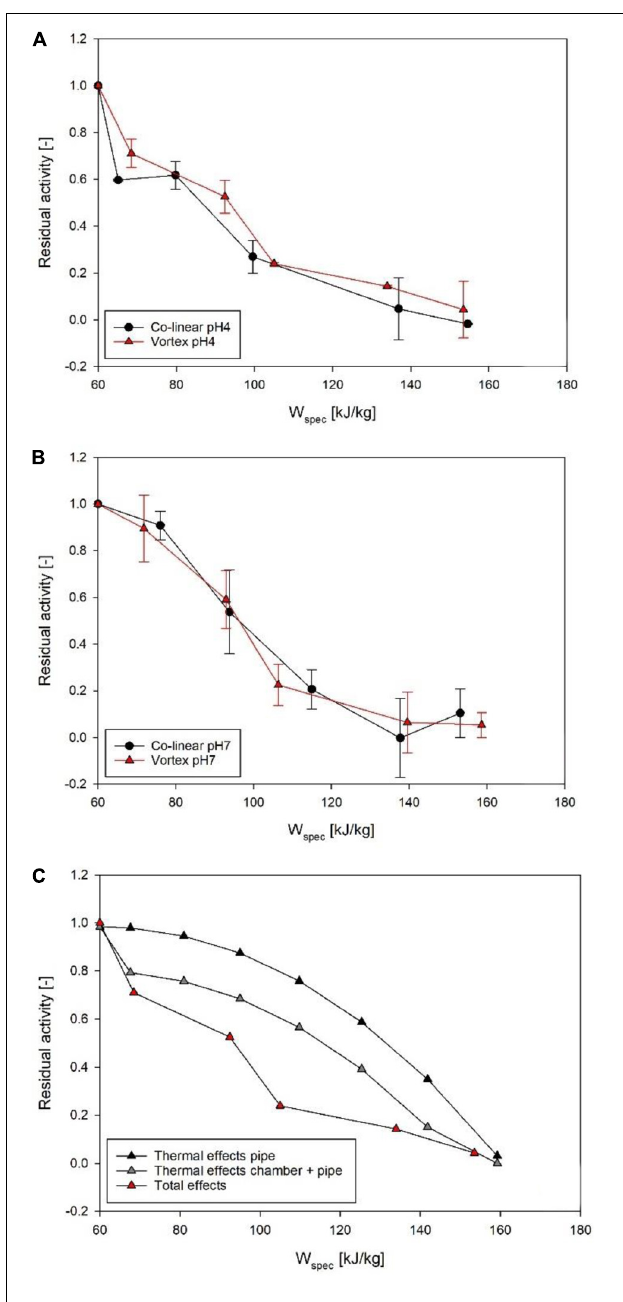
FIGURE 9 | Comparison of ALP inactivation kinetics of co-linear (black circles) and vortex (red triangles) configuration at pH 4 (A) and pH 7 (B) . Data points depict average values, error bars represent the standard deviation. Further depicted (C) is the total inactivation in the vortex chamber at pH 4, and the thermal effects occurring in the pipe after the treatment chamber, as well as inside the treatment chamber and in the pipe, as determined by mathematical modeling and